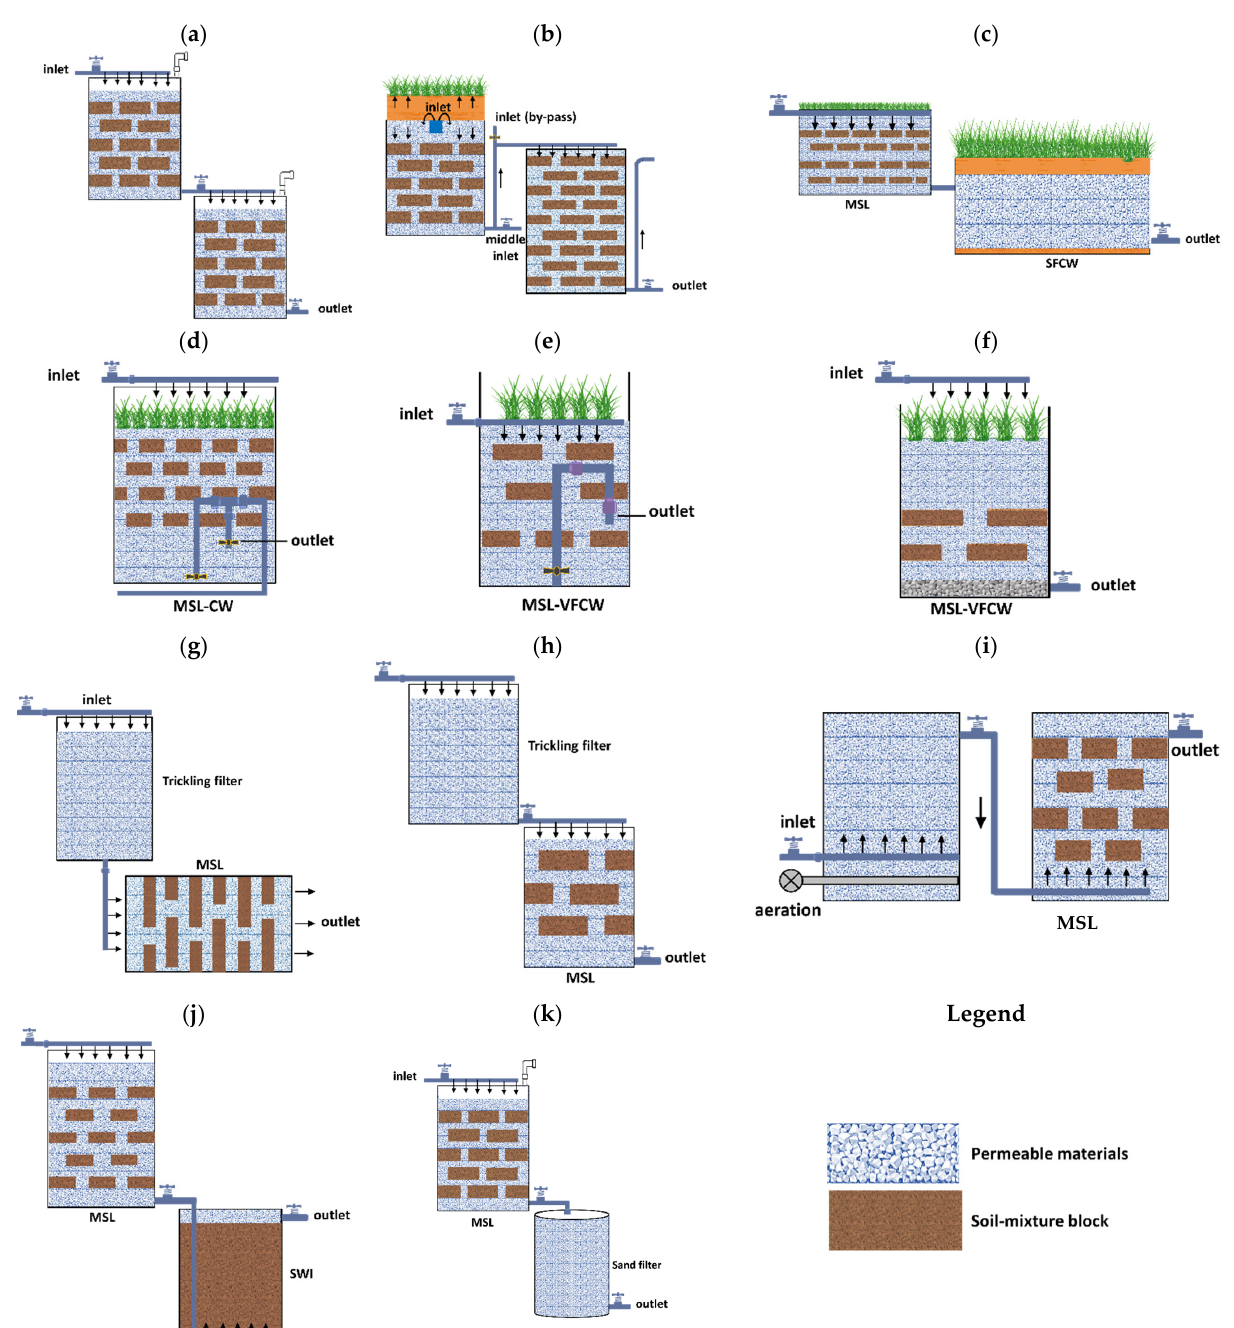
Figure 10. The simplified schematization of the multi ‐ soil ‐ layering (MSL) system combined with other technologies (VFCW = vertical flow constructed wetland; SFCW = subsurface flow constructed wetland; SWI = subsurface wastewater infiltration): ( a ) two ‐ stage vertical flow MSL, ( b ) topsoil planted MSL with vertical flow MSL, ( c ) planted vertical flow MSL with SFCW, ( d ) integrated ver ‐ tical flow MSL and VFCW, ( e ) integrated VFCW and MSL with two soil ‐ mixture layers, ( f ) inte ‐ grated VFCW and MSL with three soil ‐ mixture layers, ( g ) trickling filter with horizontal flow MSL, ( h ) trickling filter with vertical flow MSL, ( i ) blended carbon sources preceded by aeration system with vertical flow MSL, ( j ) vertical flow MSL with infiltration section based mixed soil and gravel, ( k ) vertical flow MSL with sand filter.